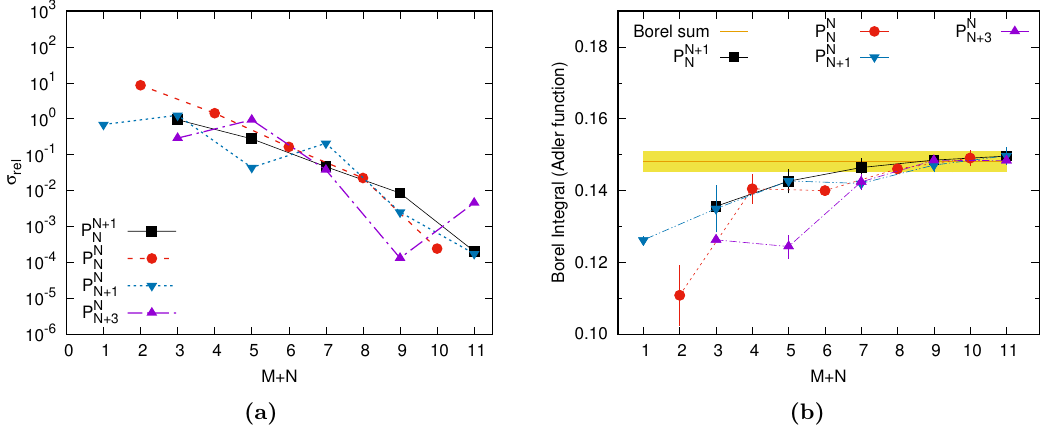
Figure 3. Results for four di(cid:11)erent Pad(cid:19)e sequences in the MS scheme. (a) Relative error of the (cid:12)rst forecast coe(cid:14)cient of the Adler function, as de(cid:12)ned in eq. (4.11). (b) Results for the Borel sum, eq. (2.10). The horizontal band gives the imaginary ambiguity of the true value.